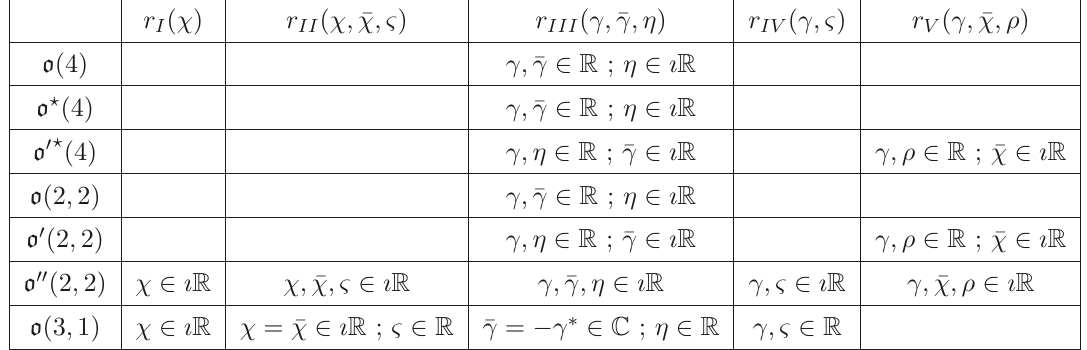
Table 1 . All real Lie bialgebras for o (4; C ), see